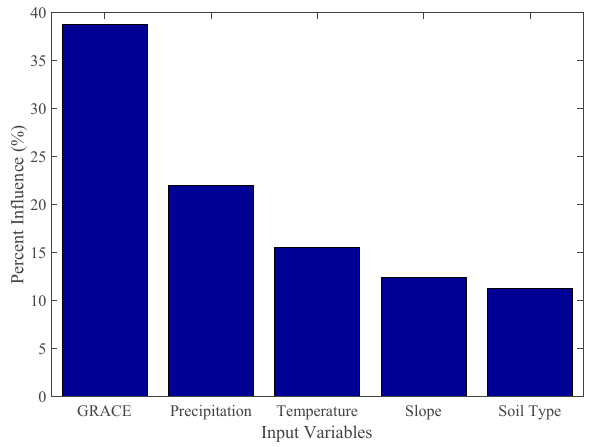
Figure 6. Percent influence of input variables on neural network model output.